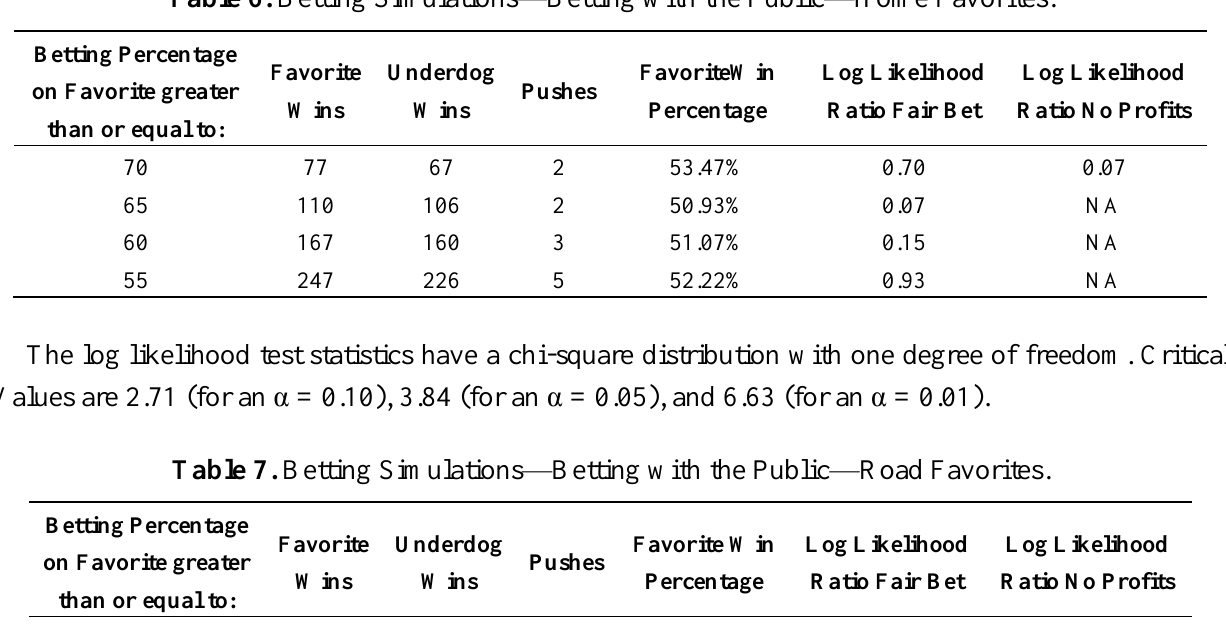
Table 6. Betting Simulations—Betting with the Public—Home Favorites.